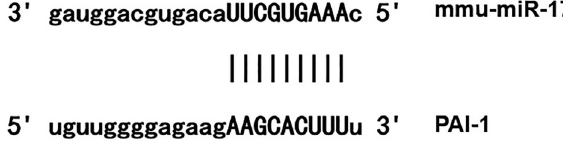
Figure 1. Direct interaction between microRNA-17 and plasmino- gen activator inhibitor-1